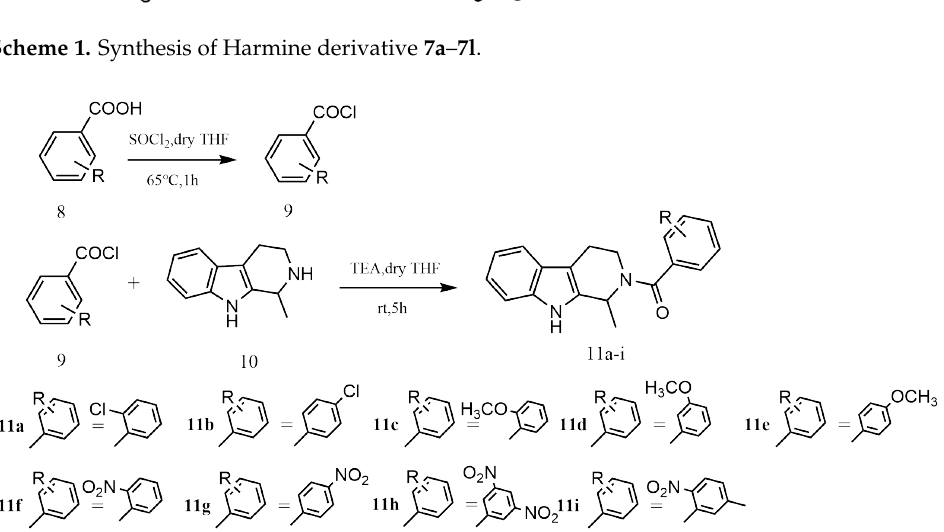
Figure 3. Spatial structure of compound 7l